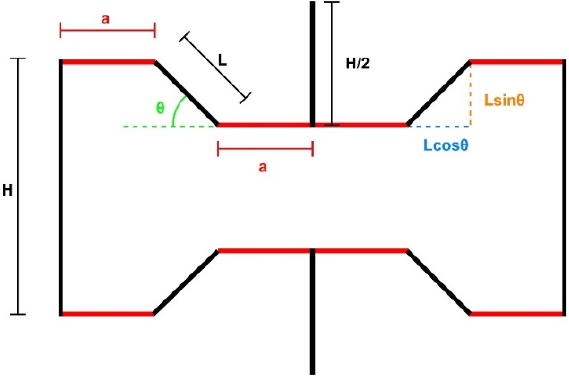
Figure 1. Unit cell of the proposed structure.